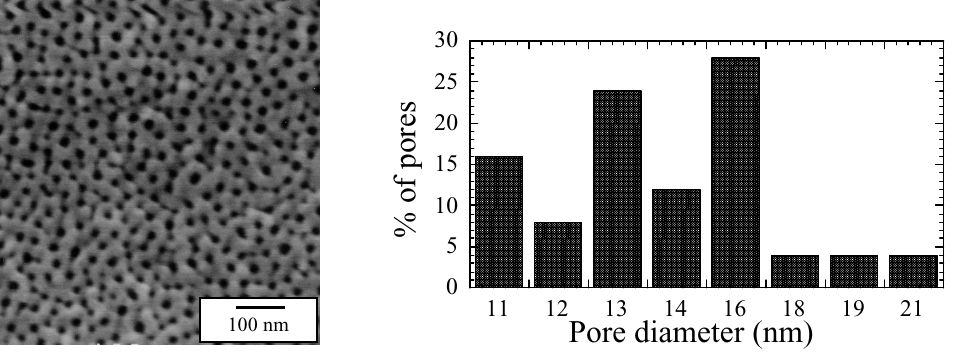
Figure 5. Field emission scanning electron microscope (FESEM) image of sensor DS15 with corresponding pore size distribution.